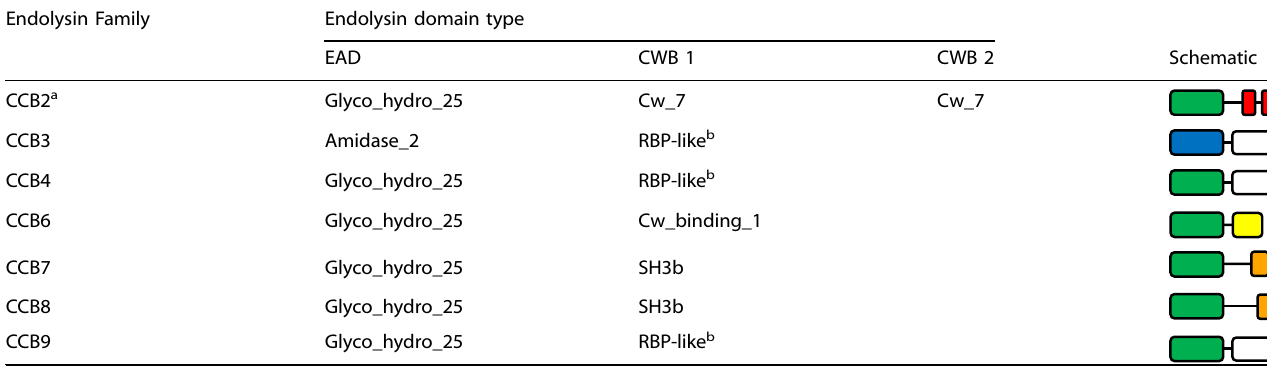
Table 1. Domain composition of anti- Gardnerella endolysin candidates.